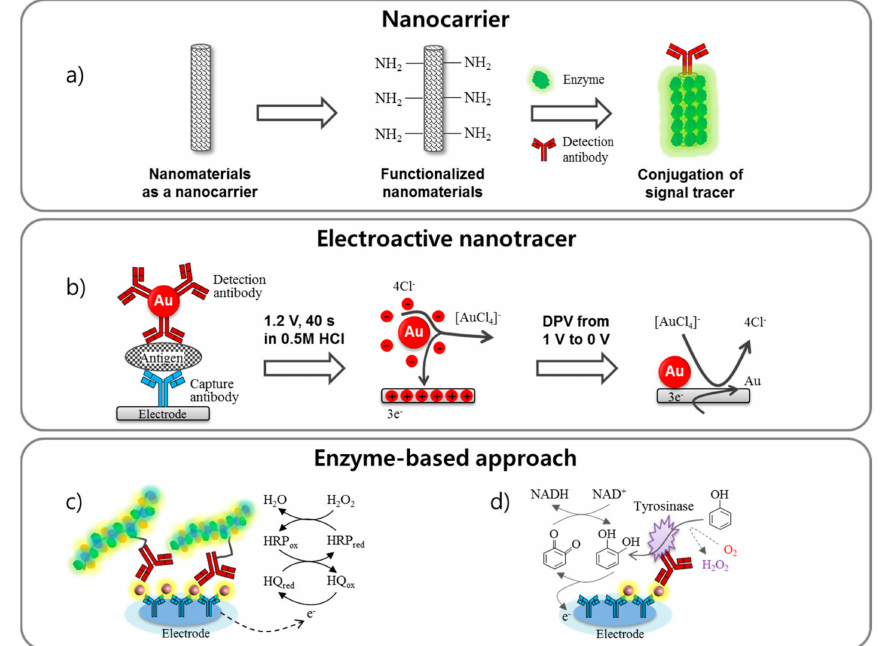
Figure 3. Schematic representation of labeling approaches for the signal amplification of electrochemical immunosensor. The labeling techniques can be categorized as ( a ) nanocarrier, ( b ) electroactive nanotracer, ( c ) enzyme-based nanopolymer and ( d ) redox cycling of enzyme reactions, which enable an electrochemical signal